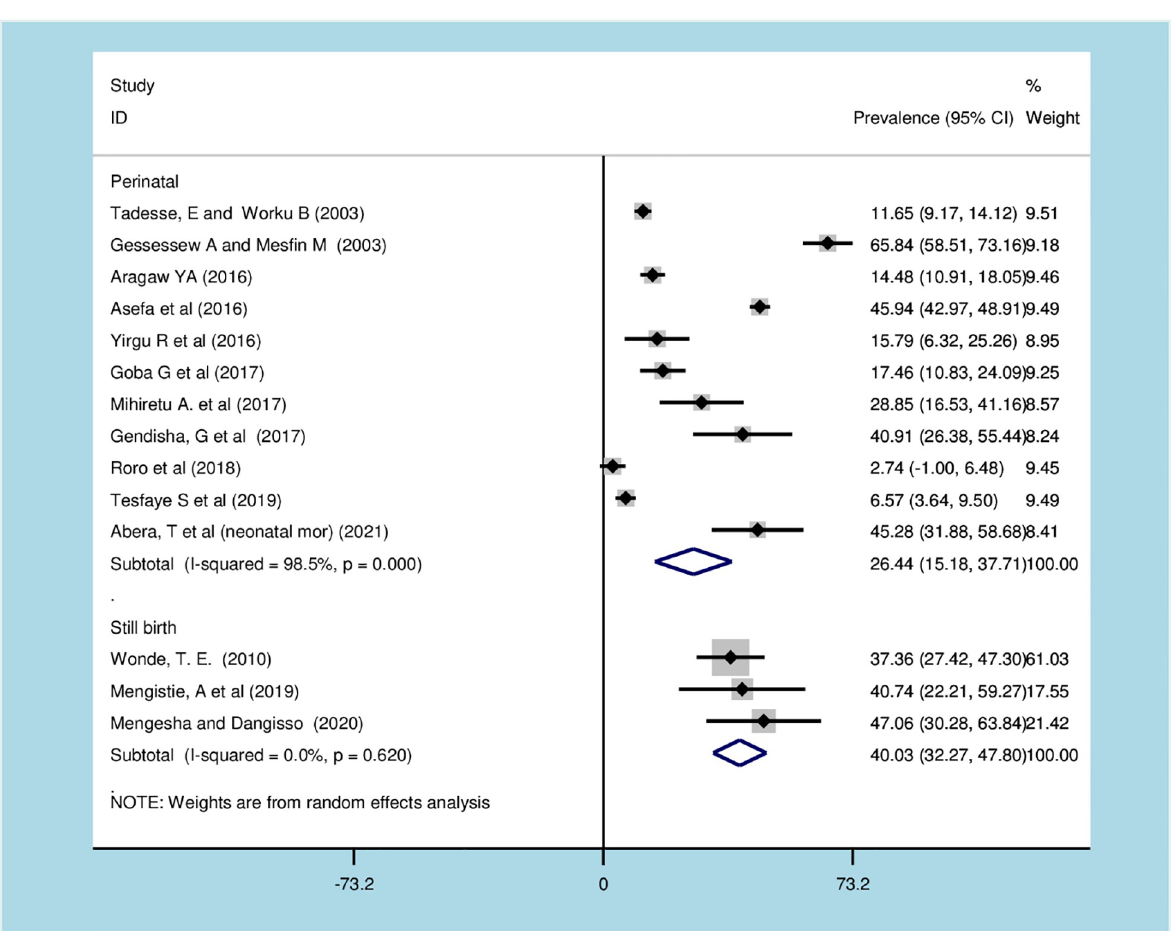
Fig 6. Forest plot of overall prevalence of perinatal death among obstructed labor women in Ethiopia, 2021.